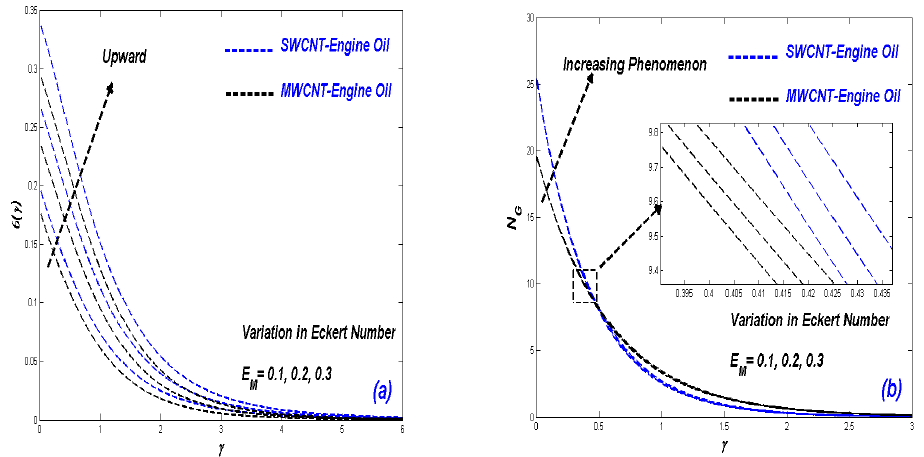
Figure 11. ( a ) Temperature change with E M ; ( b ) Entropy change with E M .